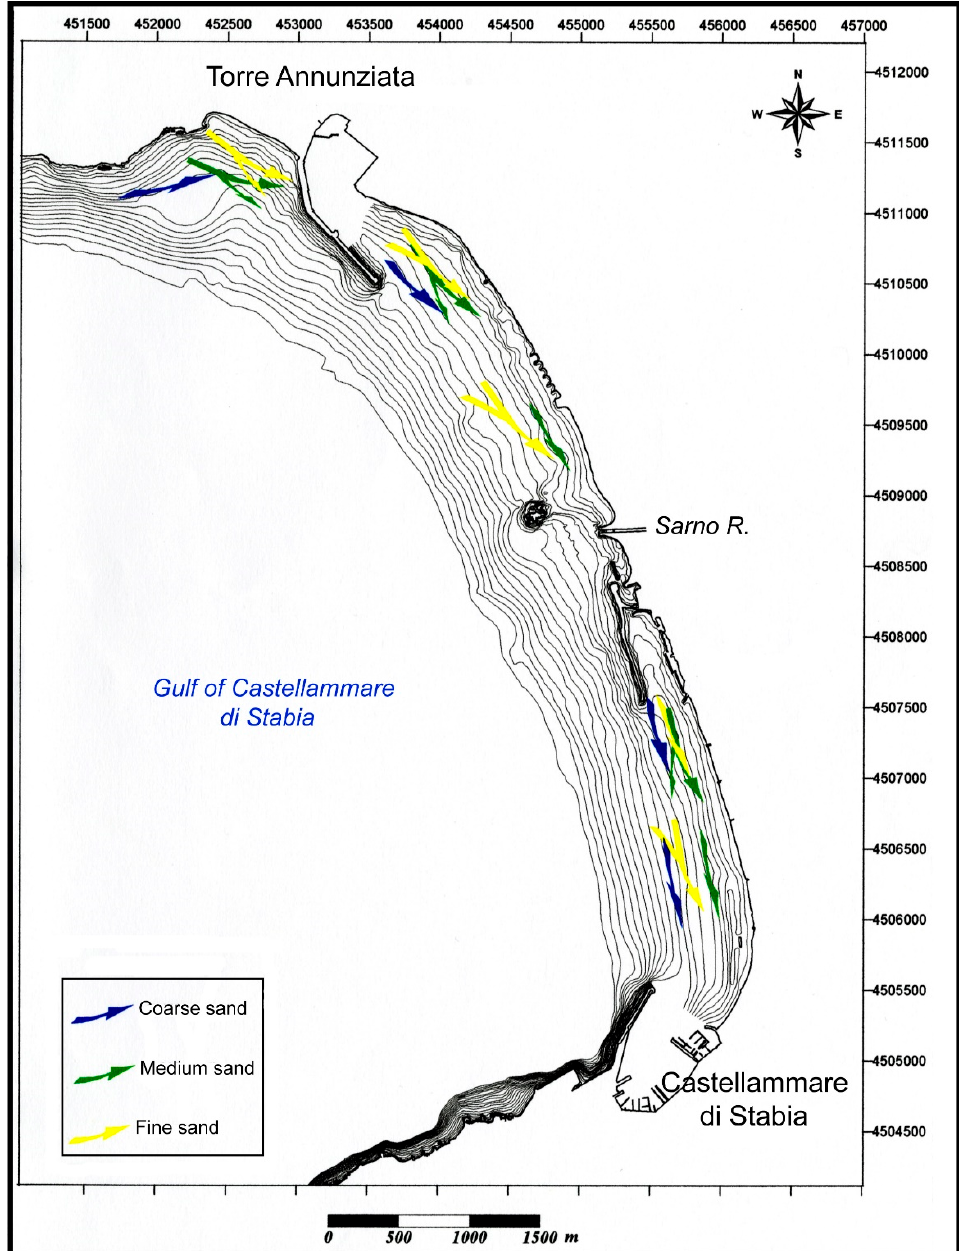
Figure 13. Vector axes of the main direction of sediment transport along the Gulf of Napoli and Castellammare di Stabia coast.